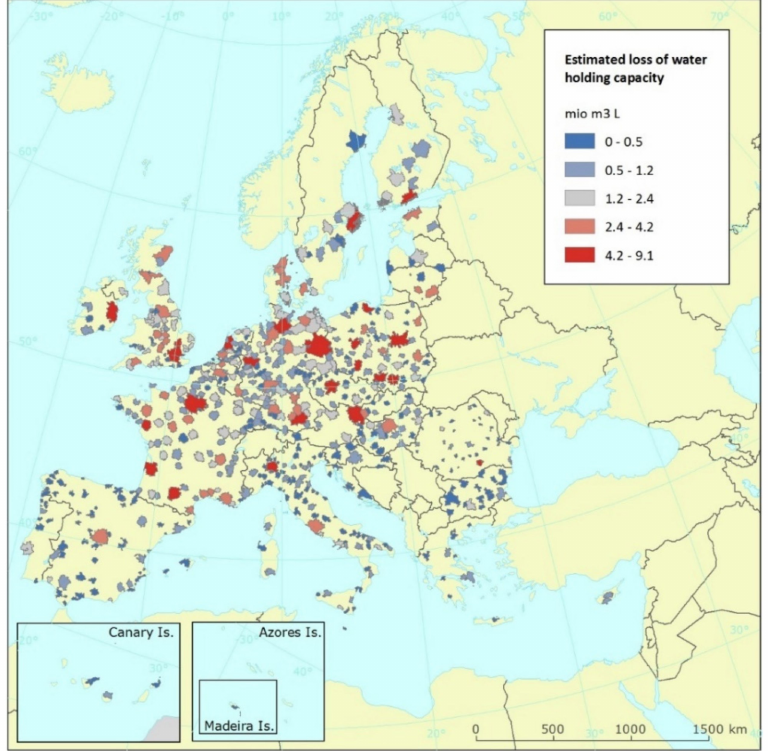
Figure 9. Estimated potential loss of water holding capacity in Functional Urban Areas because of sealing during